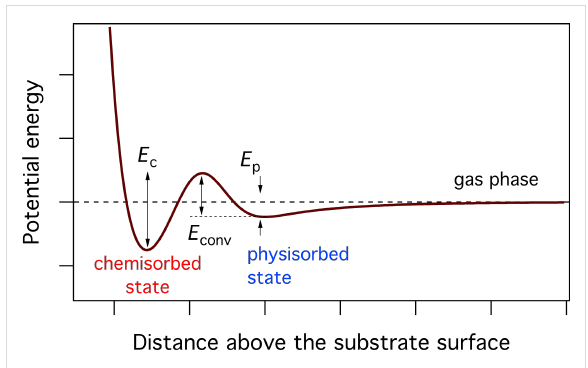
Figure 12: Potential energy diagram for the case of chemisorption governed by a potential well of depth E c and an activation barrier of height E conv . Also shown is a physisorption potential well of depth E p . Modified from [5].